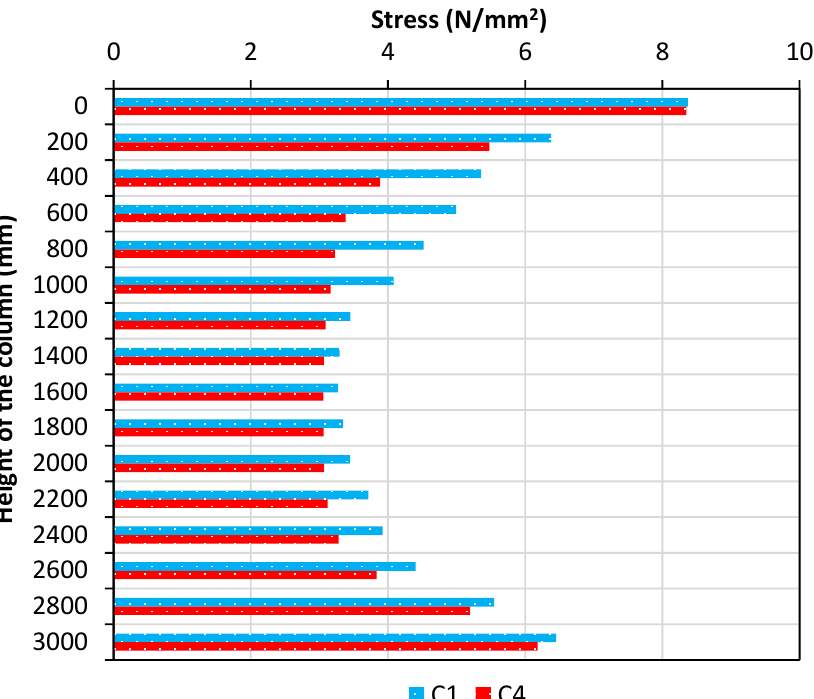
Figure 39. Stress pattern formed along the height of the column (a) C4, (b) C1